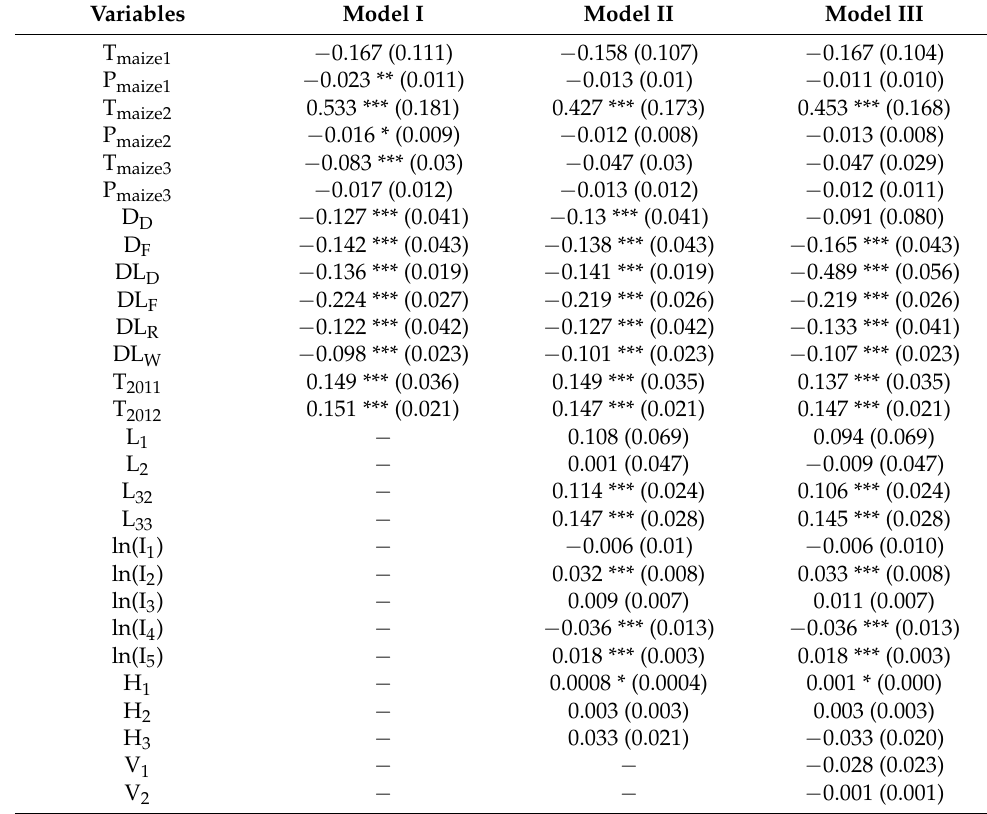
Table 7. The estimated results of influencing factors of summer maize